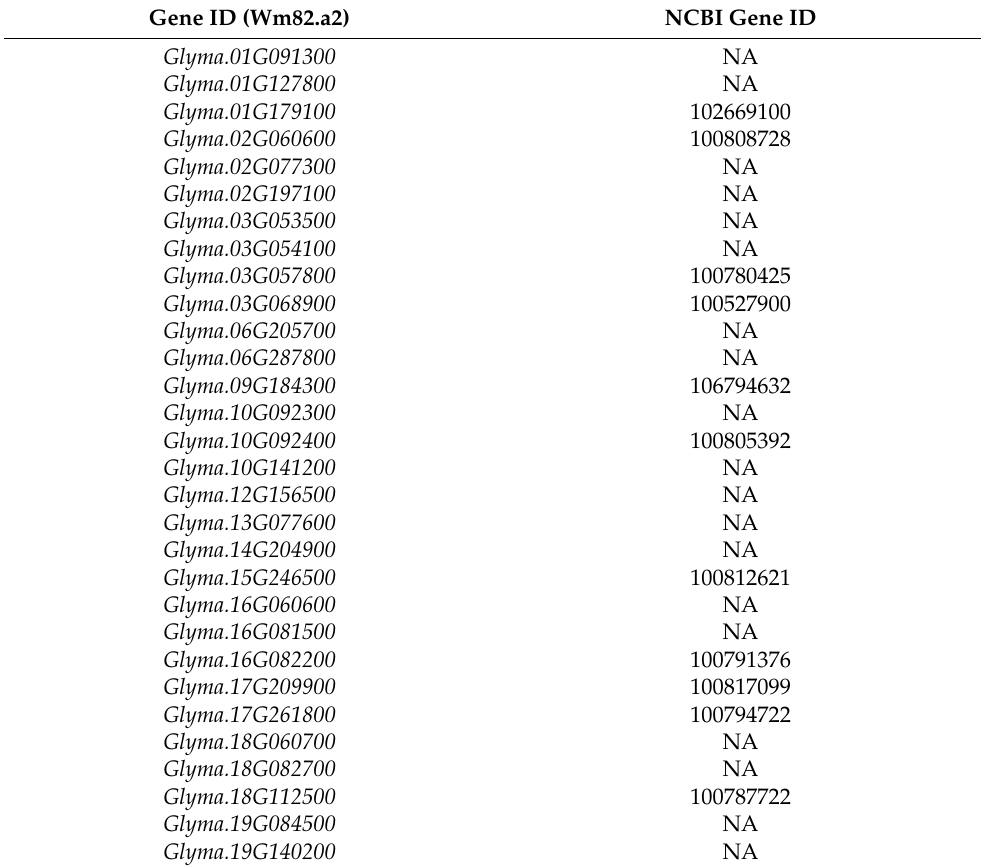
Table 4. All short-listed G. max gene IDs and corresponding NCBI Gene ID (https://www.ncbi.nlm. nih.gov/ accessed on 3 October 2022) [66]. Gene ID